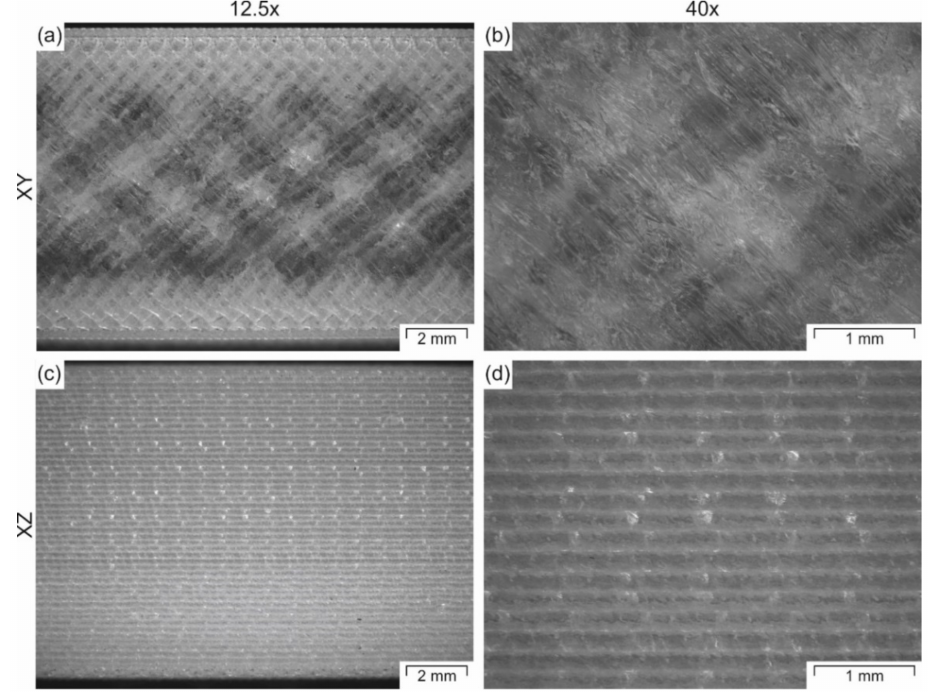
Figure 11. Microscopy images of tensile specimens printed in ( a , b ) XY-orientation or ( c , d ) XZ-orientation recorded at two di ff erent magnifications (12.5 and 40). All images were taken from the top view and laying the specimens in the